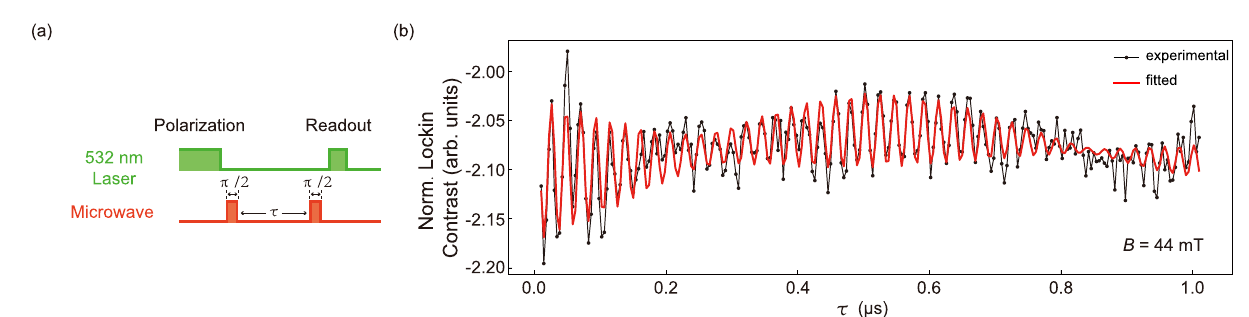
(cid:1) τ (cid:1) π . b Ramsey respectively. Three frequencies f − 1 , f 0 and f +1 are observed and two of them 2 2 form a clear beat. The distances between the adjacent frequencies are both around ~45MHz. The fi tted T * 2 corresponding to these three frequencies are ϕ * 0.665 ±0.108 μ s, 2.500±2.160 μ s and 1.448± 0.841 μ s, i , T i and b are 2 i , f i ,